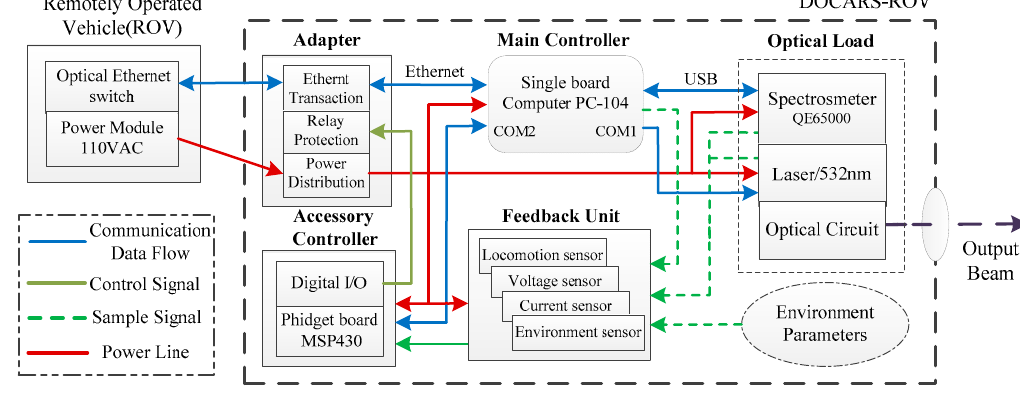
Figure 1. Schematic Diagram of DOCARS system.